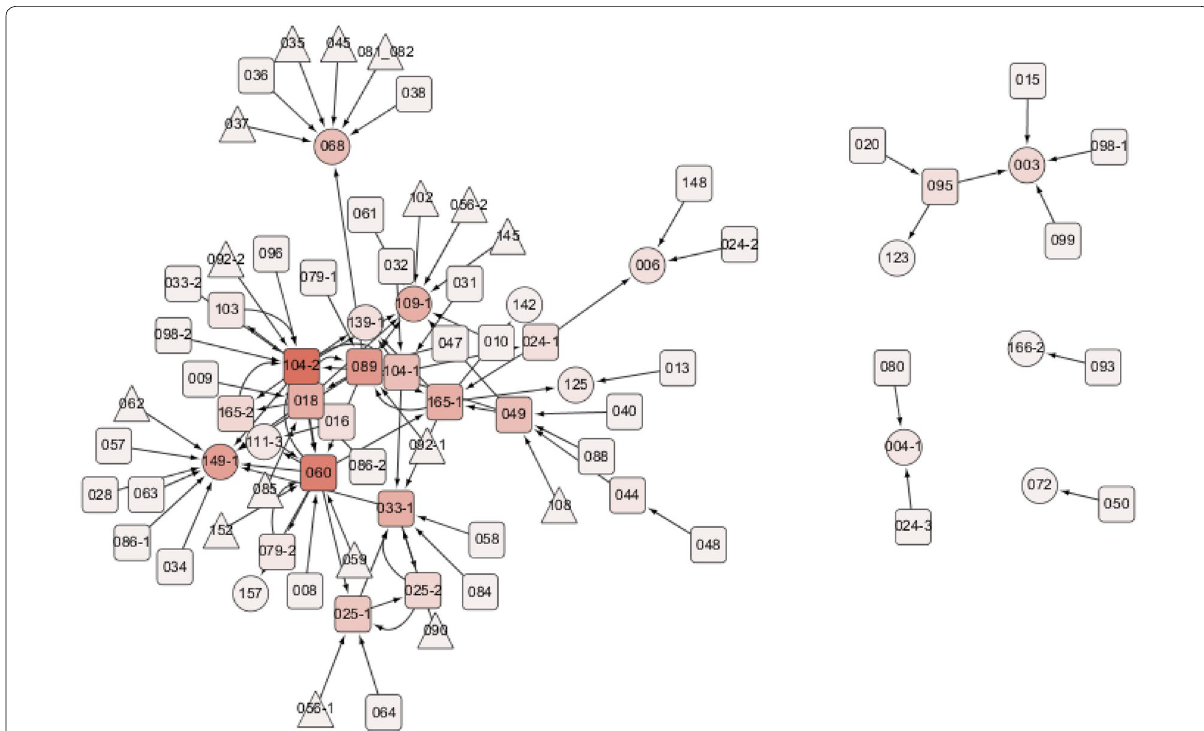
Fig. 5 Triangle nodes indicate the bHLH probes capable of binding to G‑box sequences (G‑box binders) but not having G‑box sequences in their promoter regions (being sources only); ellipse nodes indicate the bHLH probes having G‑box sequences in their promoter regions but not known as the G‑box binders (being targets only); round rectangle nodes are the G‑box binders having G‑box sequences in their promoter regions (being both sources and targets). The shade of the fill color in the node represents the total degree of the node. A list of all the probes (nodes) used in the study is provided in Additional file 2: Table S1, and the sub‑network for each source probe is in Additional file 2: Table